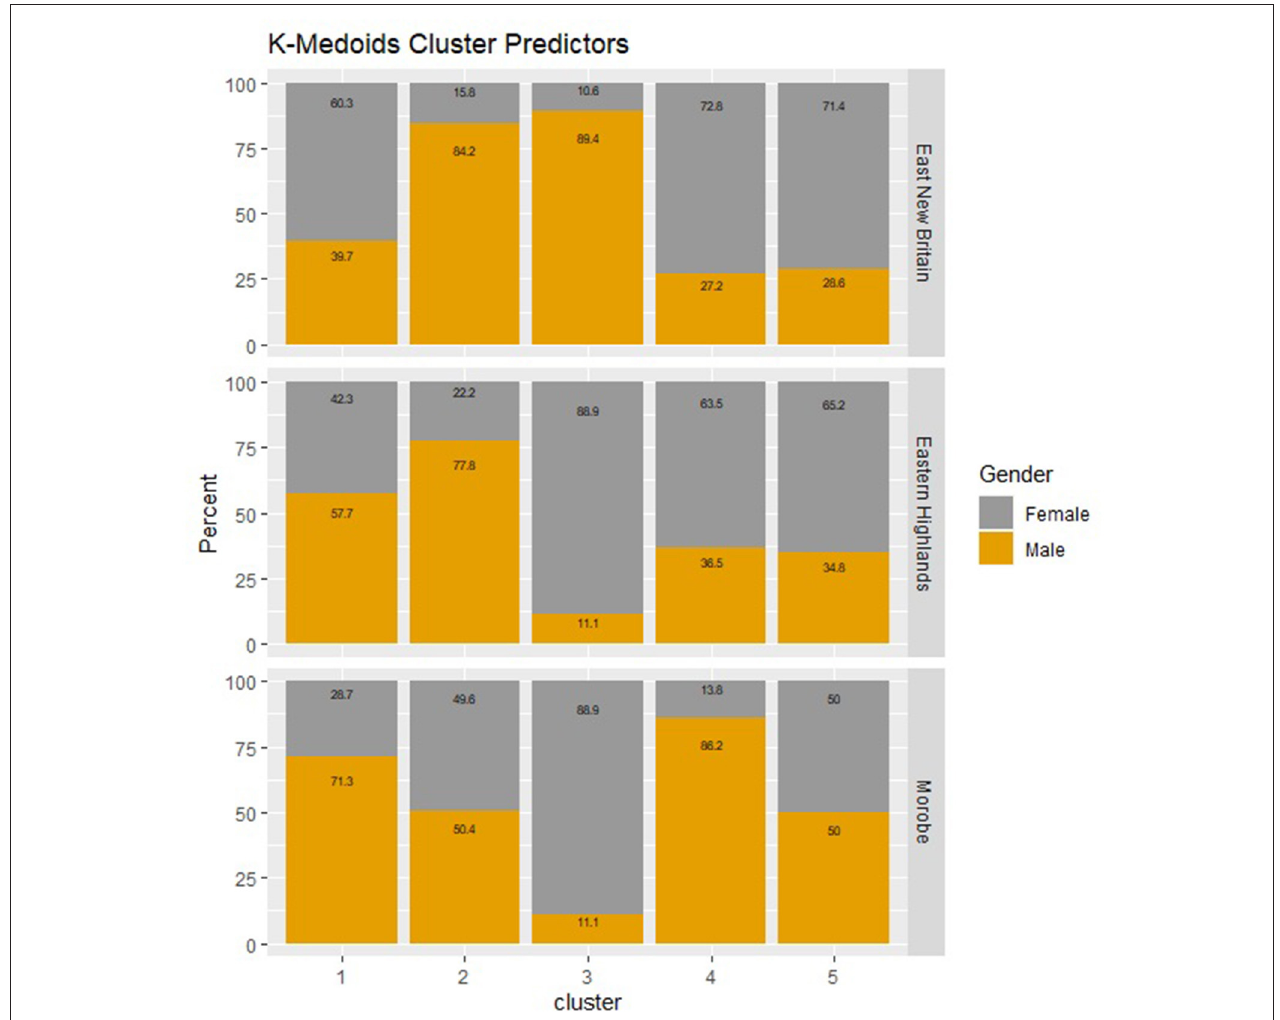
FIGURE 3 | Gender and provincial composition of cluster membership. Values are percentages within cluster.